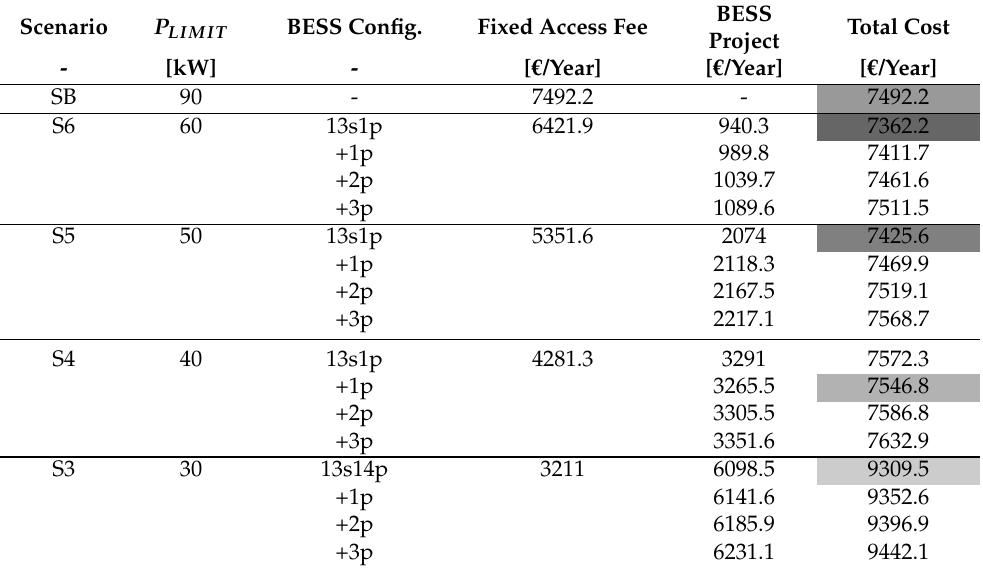
Table 7. Costs for the summer